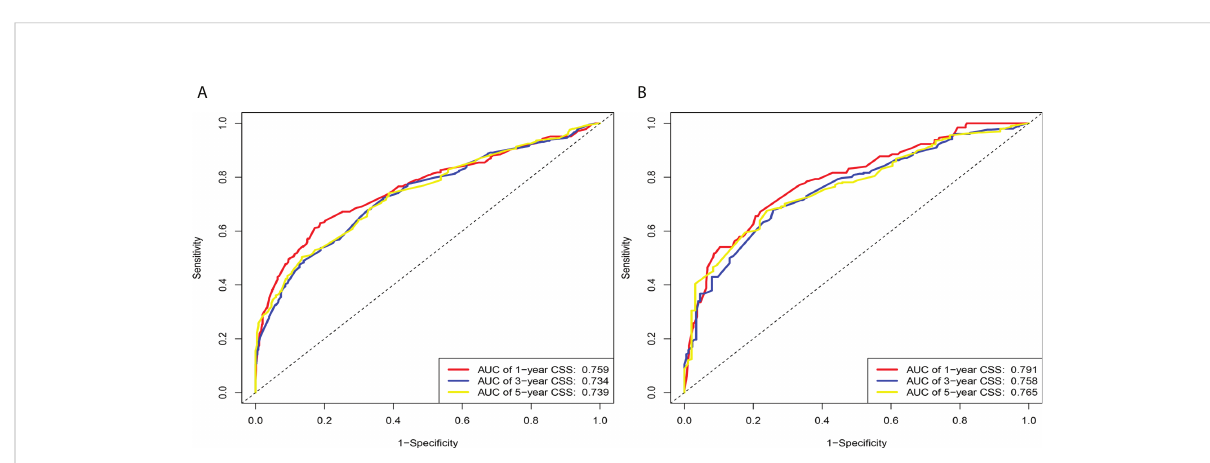
FIGURE 3 The area under the time-dependent receiver operating characteristic (ROC) curve (td-AUC) based on the nomogram. (A) Based on the training cohorts; (B) Based on the validation